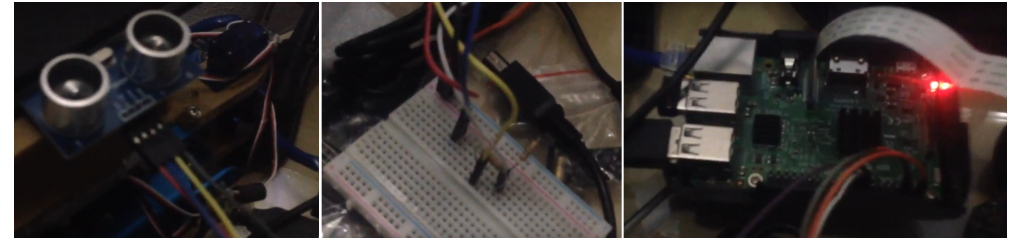
Figure 13. Practice activity with PiBot to handle an ultrasonic sensor.